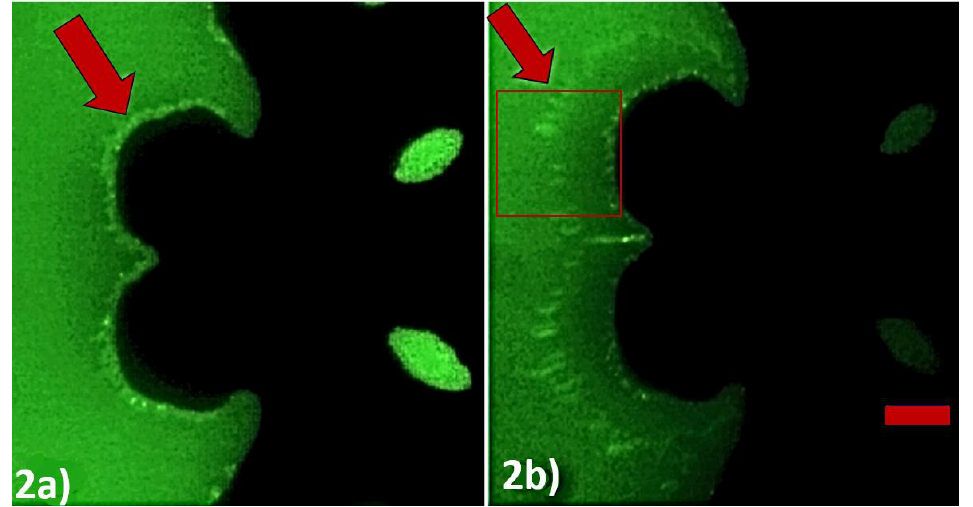
Figure 2. Experimental demonstration of negative DEP effect through time-lapse images captured through DEP spectroscopy application. The electric field was changed from 10 kHz to 0.5 MHz with 10 V peak-to-peak at t = 0 ms. ( a ) t = 0 ms and ( b ) t = 40 ms. The ssDNA sequence used for this was 5’ -(biotin) TGTTGTGCGA- 3’. The interdigitated electrode is visible as the darker region in the picture. The bright layer visible on the edge of the electrode is formed by the accumulation of PMs. The scale bar indicates 25 µm. The rectangular box depicts the region of interest processed to extract the position of the PM band as a function of the time.